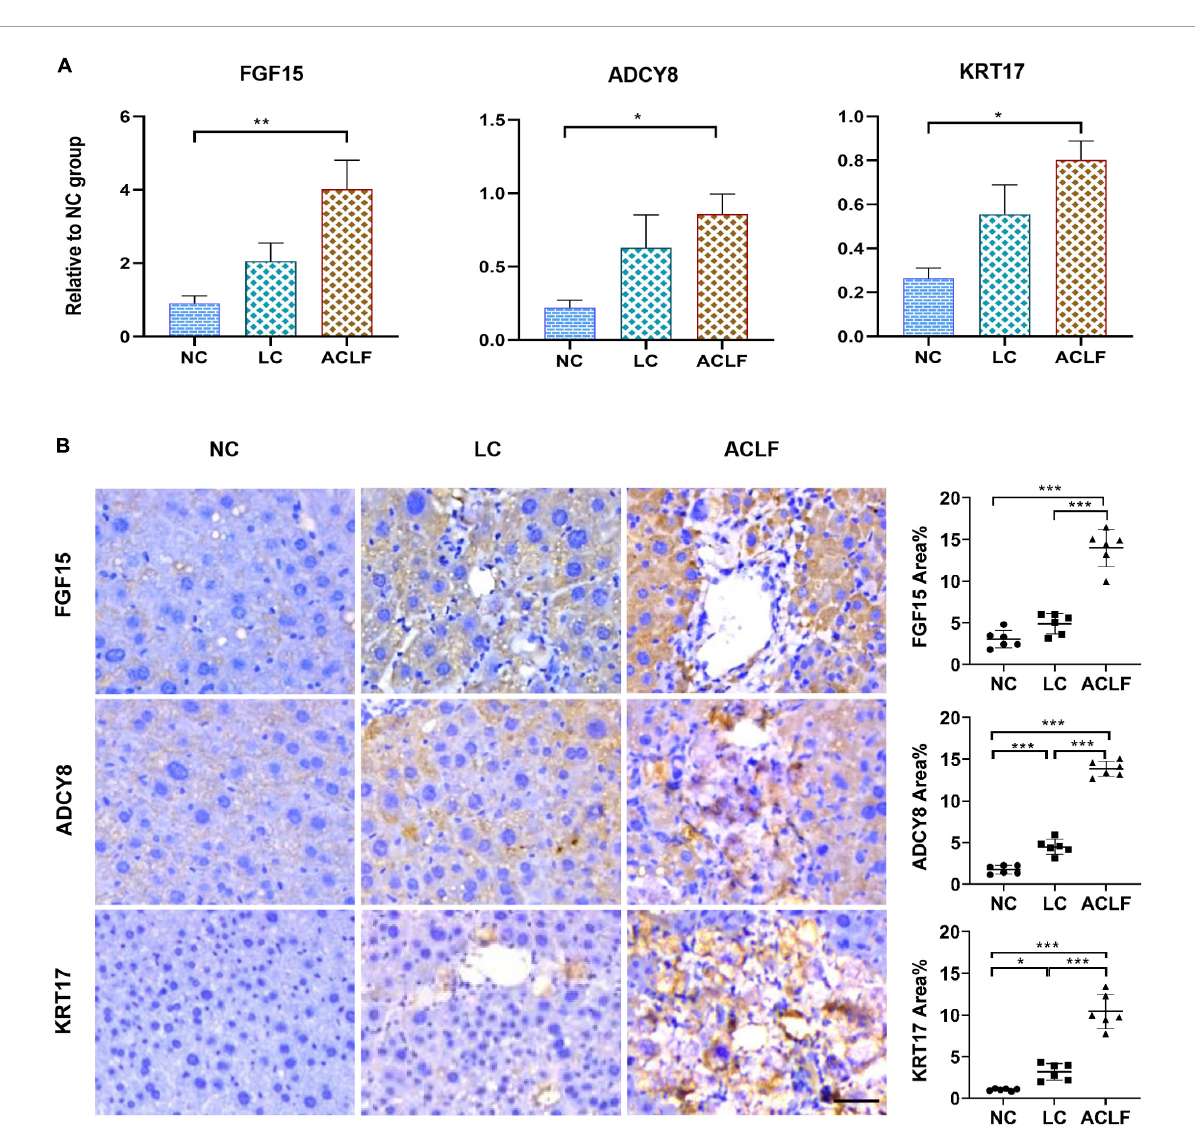
FIGURE7 Validation of the three biomarkers related to immunometabolic disorder in ACLF mouse model. (A) qRT-PCR validation of three key genes ( n = 6/6/6, ACLF/CHB/NC groups). The values are presented as the means ± SEMs. *Adjusted p < 0.05, **Adjusted p < 0.01, ***Adjusted p < 0.001. (B) Representative images of IHC staining and quantification of the three key proteins involved in ACLF development in the ACLF, LC and NC groups in the mouse model (bar = 50 µ m). The values are presented as the means ± SEMs. *Adjusted p < 0.05, **Adjusted p < 0.01, ***Adjusted p < 0.001. HBV, hepatitis B virus; ACLF, acute-on-chronic liver failure; CHB, chronic hepatitis B; NC, normal control; FGF15, fibroblast growth factor 15; ADCY8, adenylate cyclase 8; KRT17, keratin